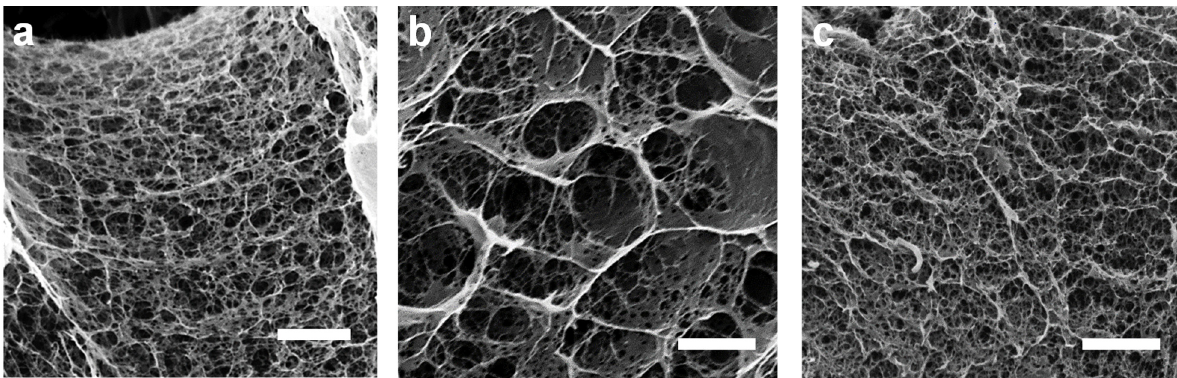
Figure 4. Scanning electron micrographs (SEM) of hydrogels printed from neat chitosan CHI 2% and 3% ( w/v ) ink formulations (( a , c ), respectively), and from CHI2/CNF0.4 ink formulation ( b ). Scale bars: 5 μ m.